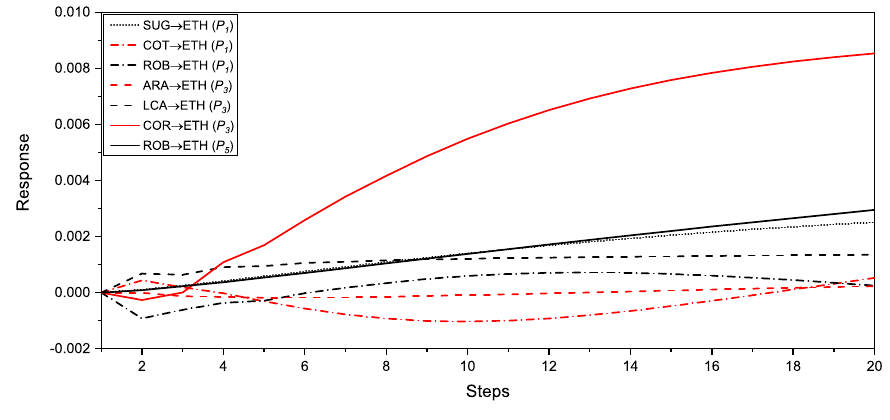
Figure 3. The responses of the ethanol prices from an orthogonal impulse (OIR) in the agricultural commodities